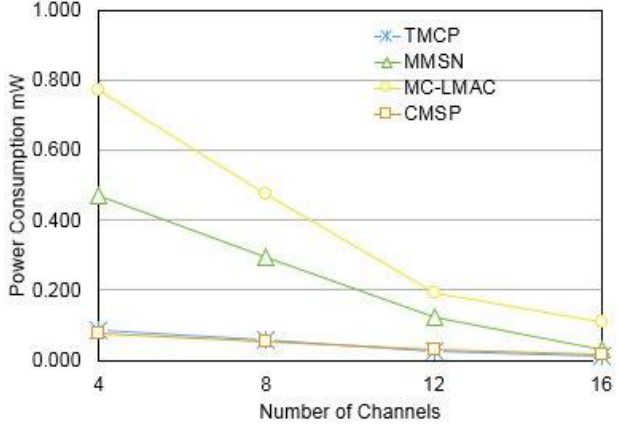
Figure 5. Power consumption vs. number of channels.